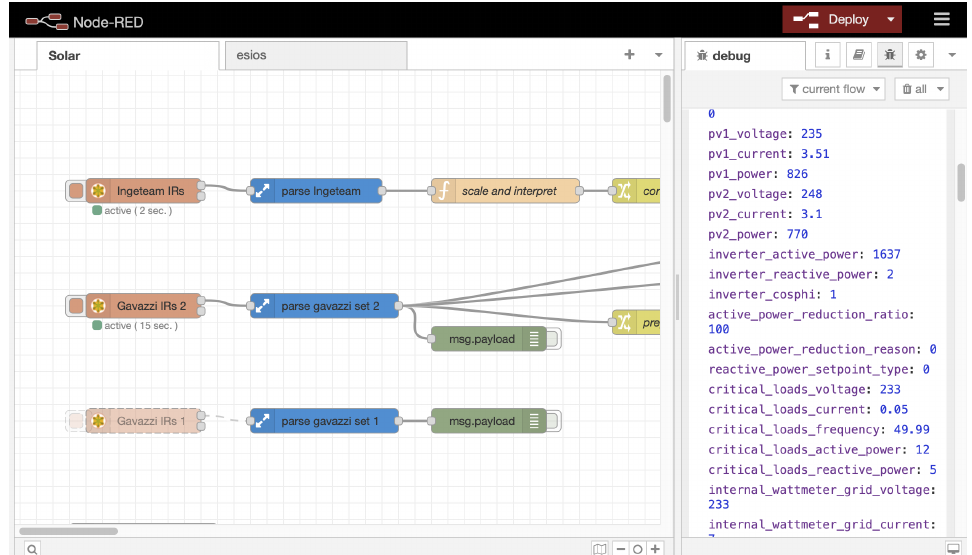
Figure 18. Node-RED development of the DER component for PV.